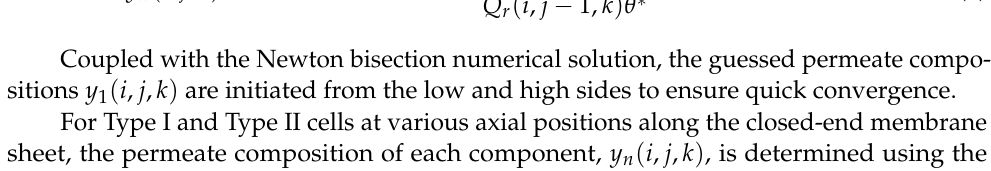
Coupled with the Newton bisection numerical solution, the guessed permeate compo- sitions y 1 ( i , j , k ) are initiated from the low and high sides to ensure quick convergence. For Type I and Type II cells at various axial positions along the closed-end membrane sheet, the permeate composition of each component, y n ( i , j , k ) , is determined using the solution procedure outlined. After determining permeate composition, total flow rate of each component into the permeate stream, 𝑄(cid:4662) (cid:3041) (𝑖, 𝑗, 𝑘) , the flow rate into the permeate stream, 𝑄(cid:4662) (cid:3043) (𝑖, 𝑗, 𝑘) , the retentate stream flow rate, 𝑄(cid:4662) (cid:3045) (𝑖, 𝑗, 𝑘) , and the retentate stream com-